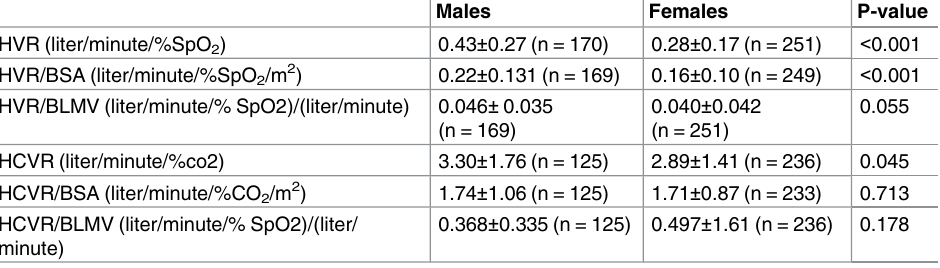
Table 3. Hypoxic (HVR) and hypercapnic (HCVR) ventilatory responses in males vs females. Males Females P-value HVR (liter/minute/%SpO 2 ) 0.43 ± 0.27 (n = 170) 0.28 ± 0.17 (n = 251) < 0.001 HVR/BSA (liter/minute/%SpO 2 /m 2 ) 0.22 ± 0.131 (n = 169) 0.16 ± 0.10 (n = 249) < 0.001 HVR/BLMV (liter/minute/% SpO2)/(liter/minute) 0.046 ± 0.035 0.040 ± 0.042 0.055 (n = 169) (n = 251) HCVR (liter/minute/%co2) 3.30 ± 1.76 (n = 125) HCVR/BSA (liter/minute/%CO 2 /m 2 ) 1.74 ± 1.06 (n = 125) HCVR/BLMV (liter/minute/% SpO2)/(liter/ 0.368 ± 0.335 (n = 125) 0.497 ± 1.61 (n = 236) minute)